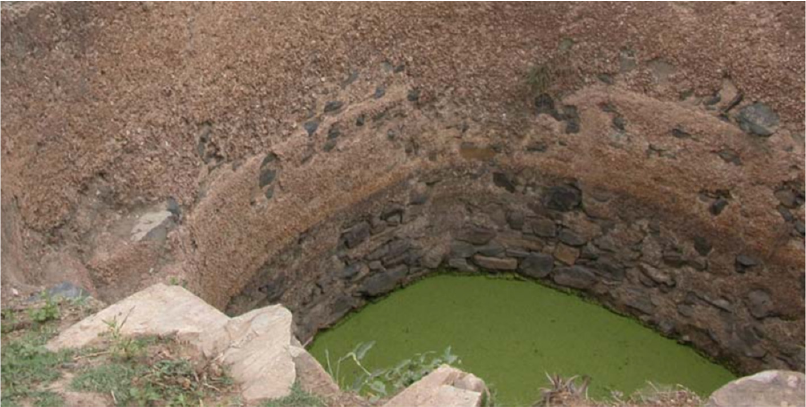
Figure 6. Duckweed mat covering the water surface of the cistern at Jabal éIbrahim, Himlan. From [56] with permission.